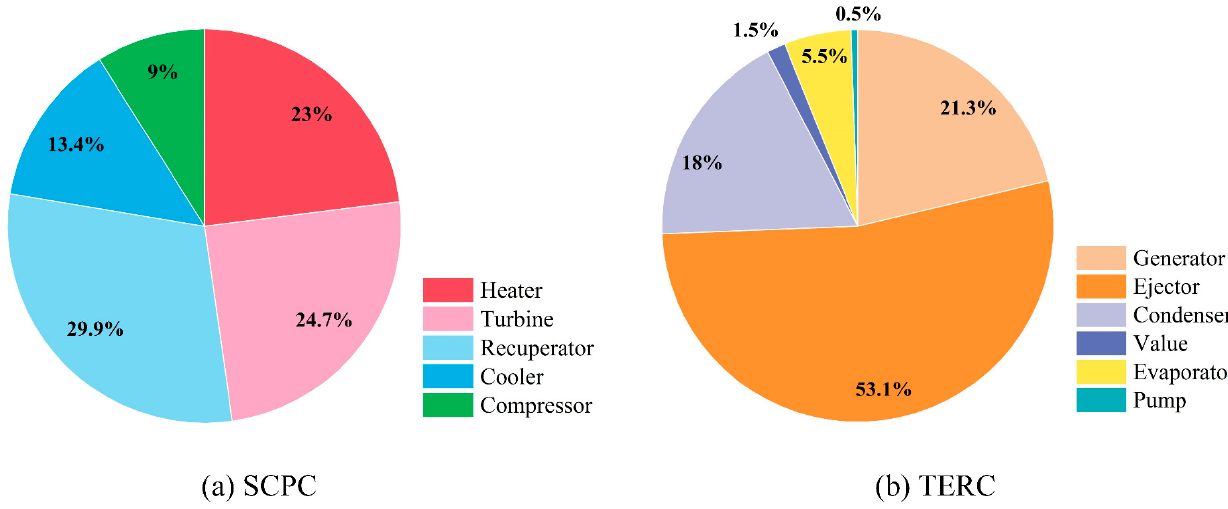
Figure 6. The exergy destruction ratio of components in the two cycles: ( a ) SCPC; ( b ) TERC.